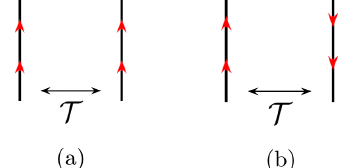
FIG. 7. The same loop wave function as in Fig. 6, but with different time-reversal actions. (a) Time reversal keeps both the color and the direction of each loop, which describes E electric picture. (b) Time reversal keeps the color but inverts the direction of each loop, which describes E